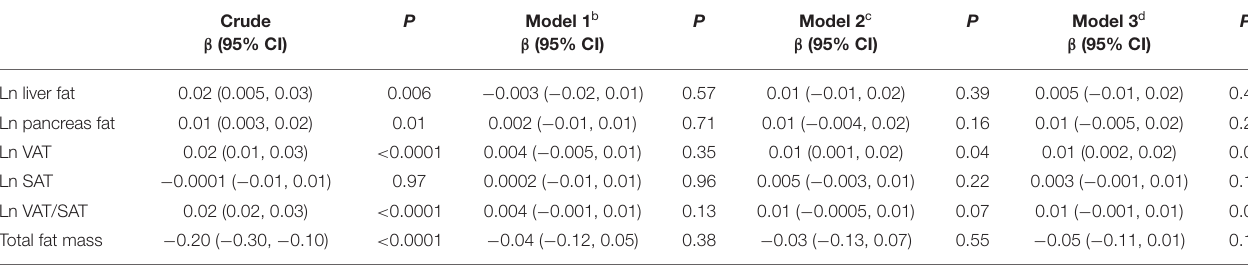
TABLE 3 | Linear regression analyses between ultra-processed food (%E) and fat depots a